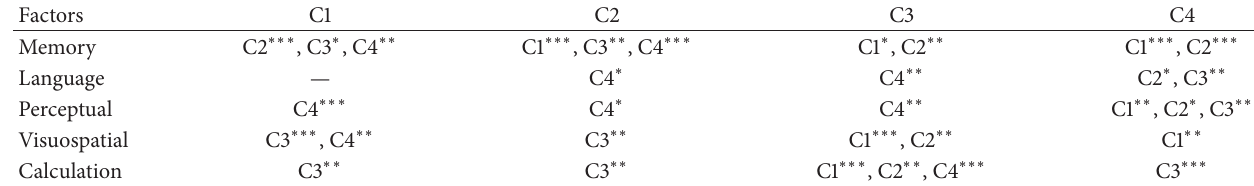
Table 4: Post hoc comparisons (Fisher) across clusters (C) for each factor